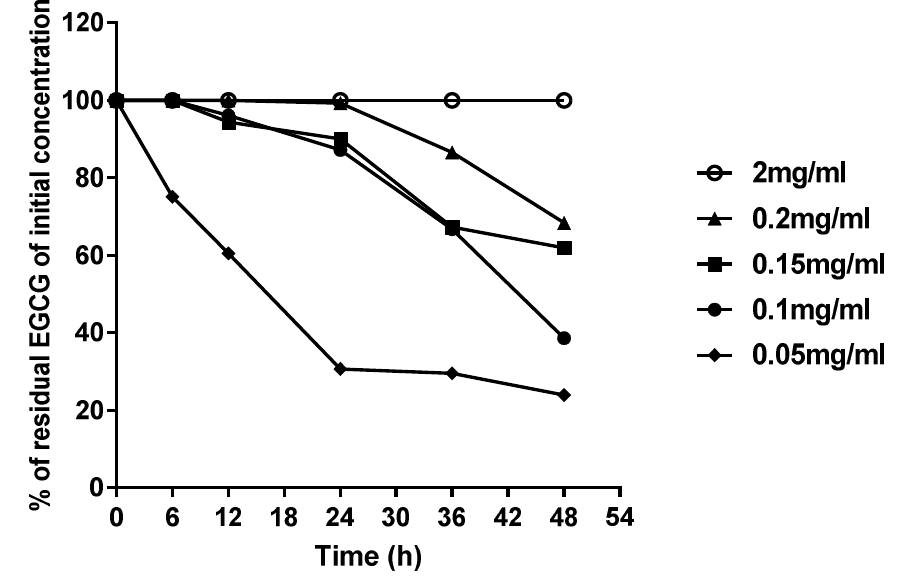
Figure 2. Stability of all concentrations of EGCG aqueous solutions under condition (A): exposed to neither sunlight nor air.